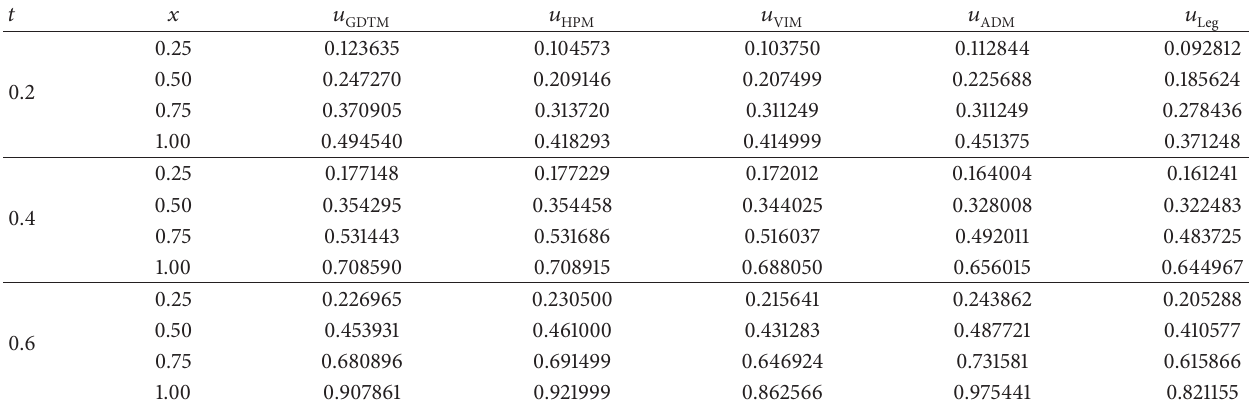
Table 3: Numerical values when 𝛼 = 0.5 .